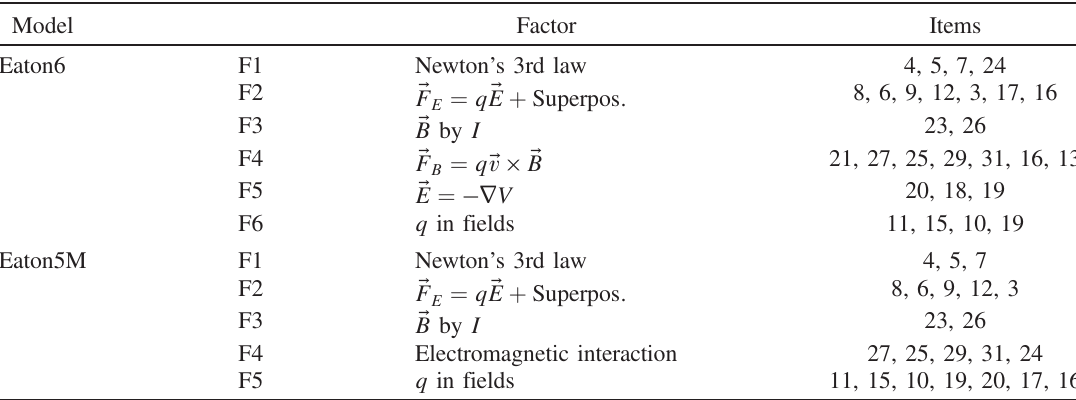
TABLE II. The two factor models of CSEM examined in this study. Note that in the Eaton6 model, items 1, 2, 14, 22, 28, 30, and 32 were excluded and in the Eaton5M model, items 1, 2, 13, 14, 18, 21, 22, 28, 30, and 32 were